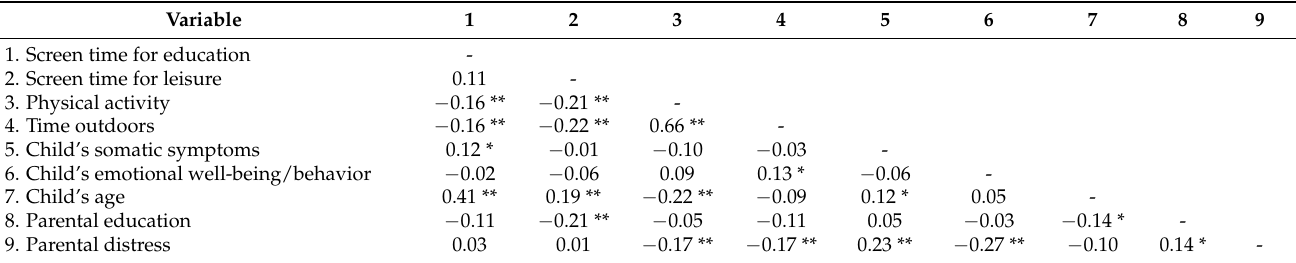
Table 2. Bivariate correlations among study